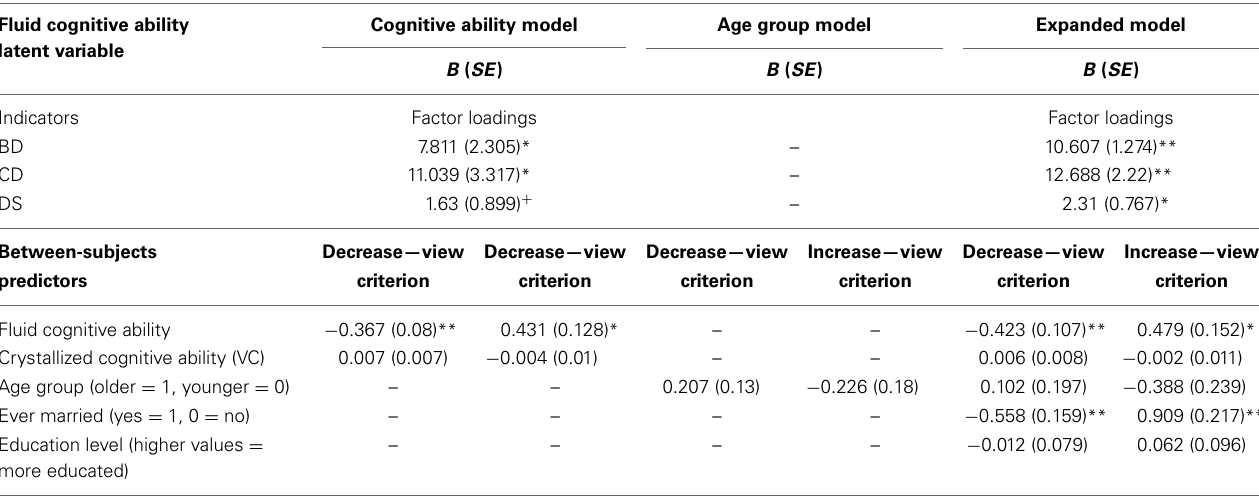
Table 3 | Parameter estimates from hypothesis tests examining cognitive ability or age group as predictors of cognitive reappraisal success. Fluid cognitive